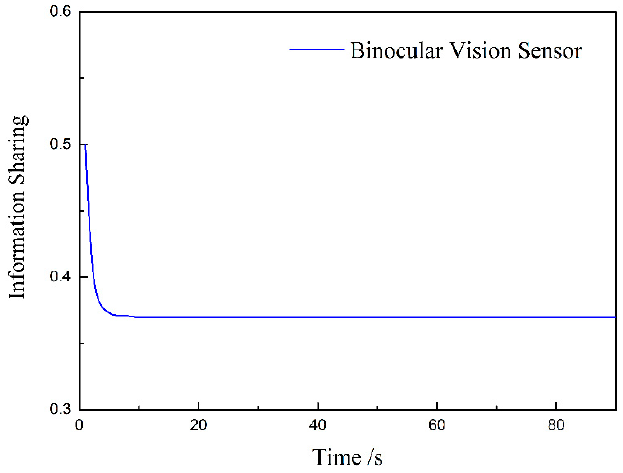
Figure 7. The binocular vision information distribution.